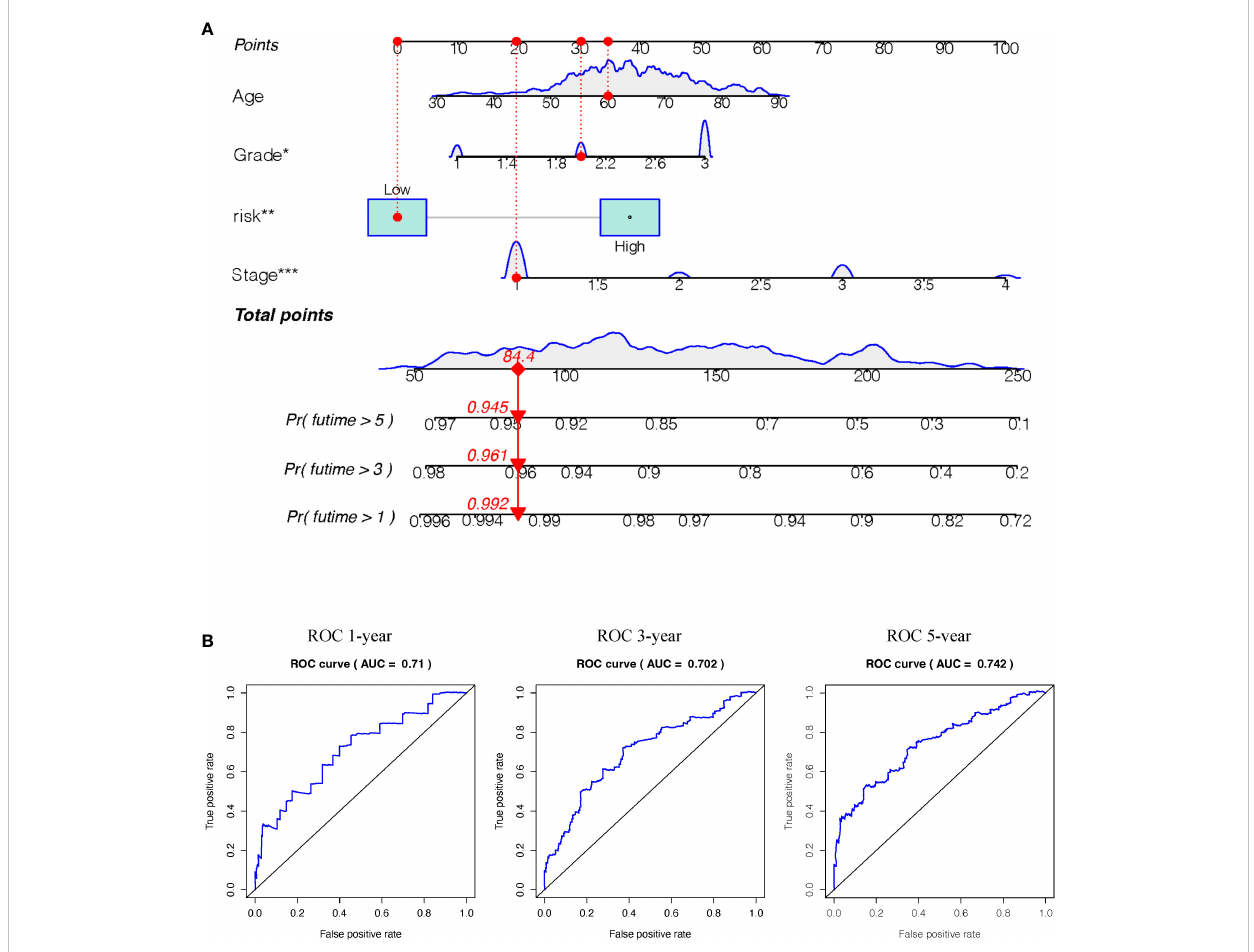
FIGURE 7 (A) Nomogram (for OS) that integrated the clinicopathologic risk factors. To calculate the probability of status, the points identi fi ed on the scale for all the variables are summed up and a vertical line was drawn from the total points scale to the probability scale.(Stage: 1 means FIGO stage1, 2means FIGO stage2, 3 means FIGO stage3, 4 means FIGO stage4. Grade: 1 means well-differentiated, 2 means moderately differentiated, 3 means poorly differentiated) (B) ROC curves showing the predictive accuracy (1-, 3-, 5-year AUC) of the nomogram for OS in testing and validation cohorts. (*P<0.05, **P<0.01,